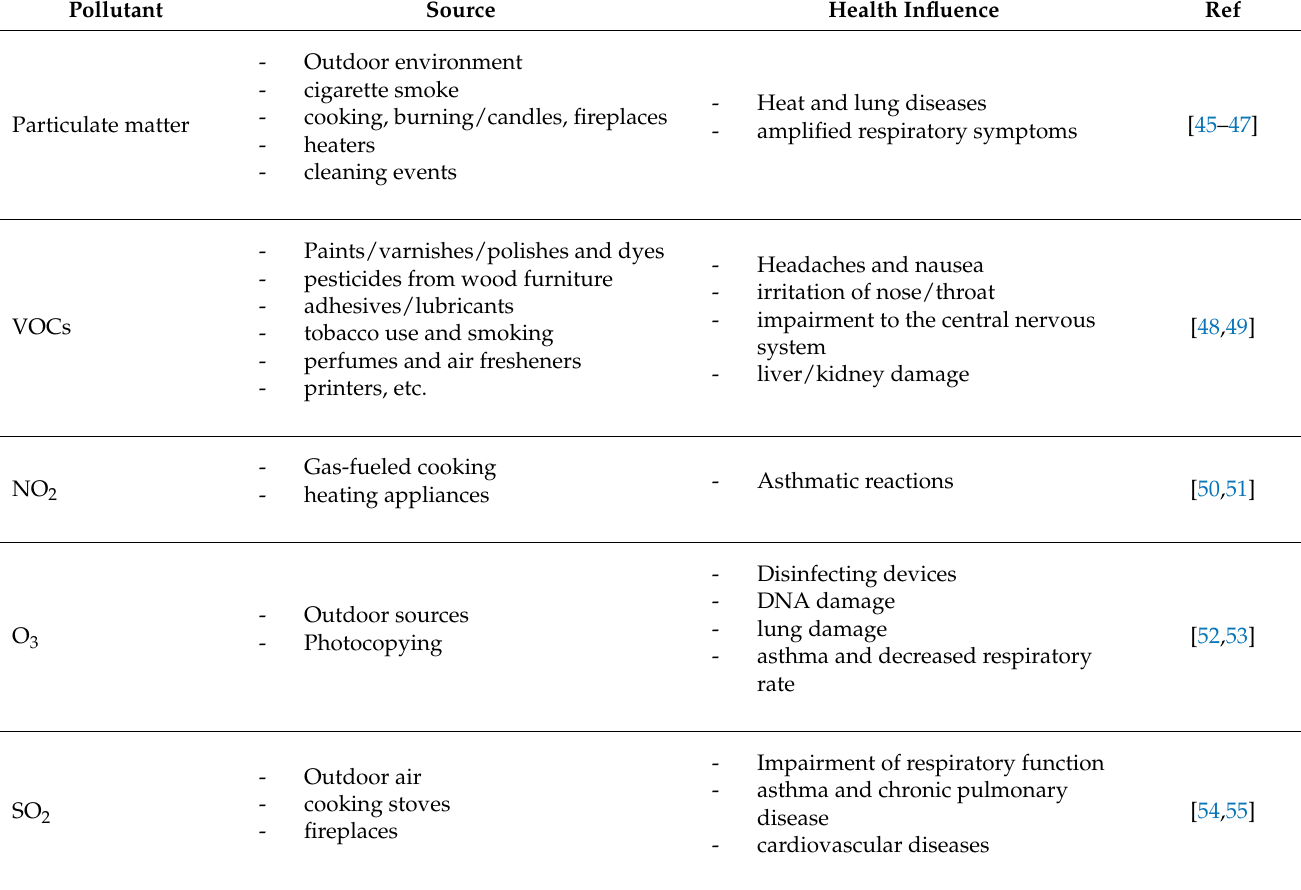
Table 1. Common indoor pollutants and their effects on human